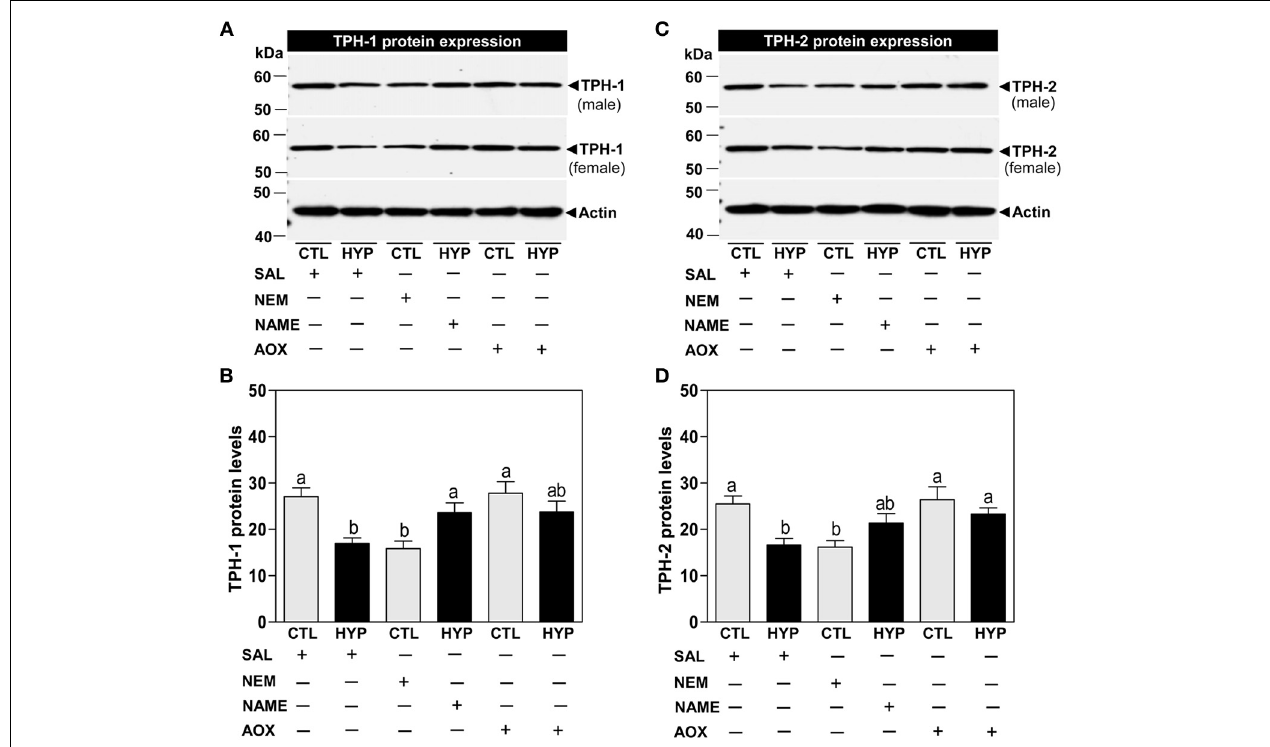
FIGURE 2 | Interactive effects of hypoxia and pharmacological agents that modulate generation of ROS and RNS on TPHs protein expression determined by Western blot analysis in croaker hypothalamus. Effects of hypoxia (DO: 1.7mg/L for 4 weeks) exposure and pharmacological treatments with NEM, NAME, and AOX on immunoreactive (IR) expression and IR intensity of TPH-1 (A,B) and TPH-2 (C,D) protein in croaker hypothalamus.